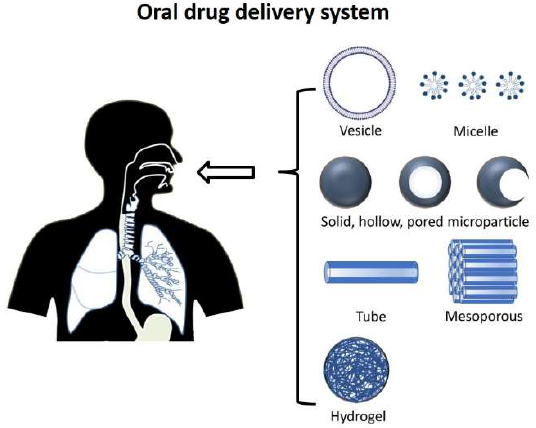
Figure 3. Schematic illustration of the principle oral vehicles designs.